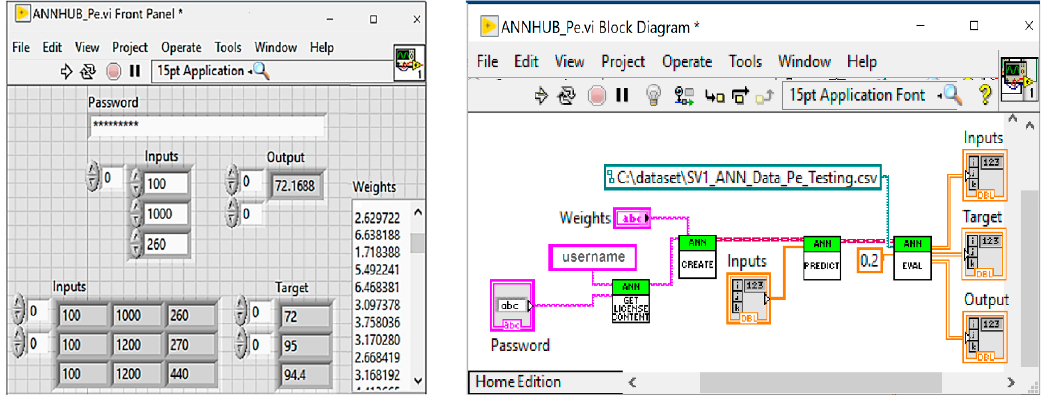
Figure 13. Secured LabVIEW application programming interface (API) to access the “cloud AI” ANNHUB—Pe predictions are compared with the “target” test values.